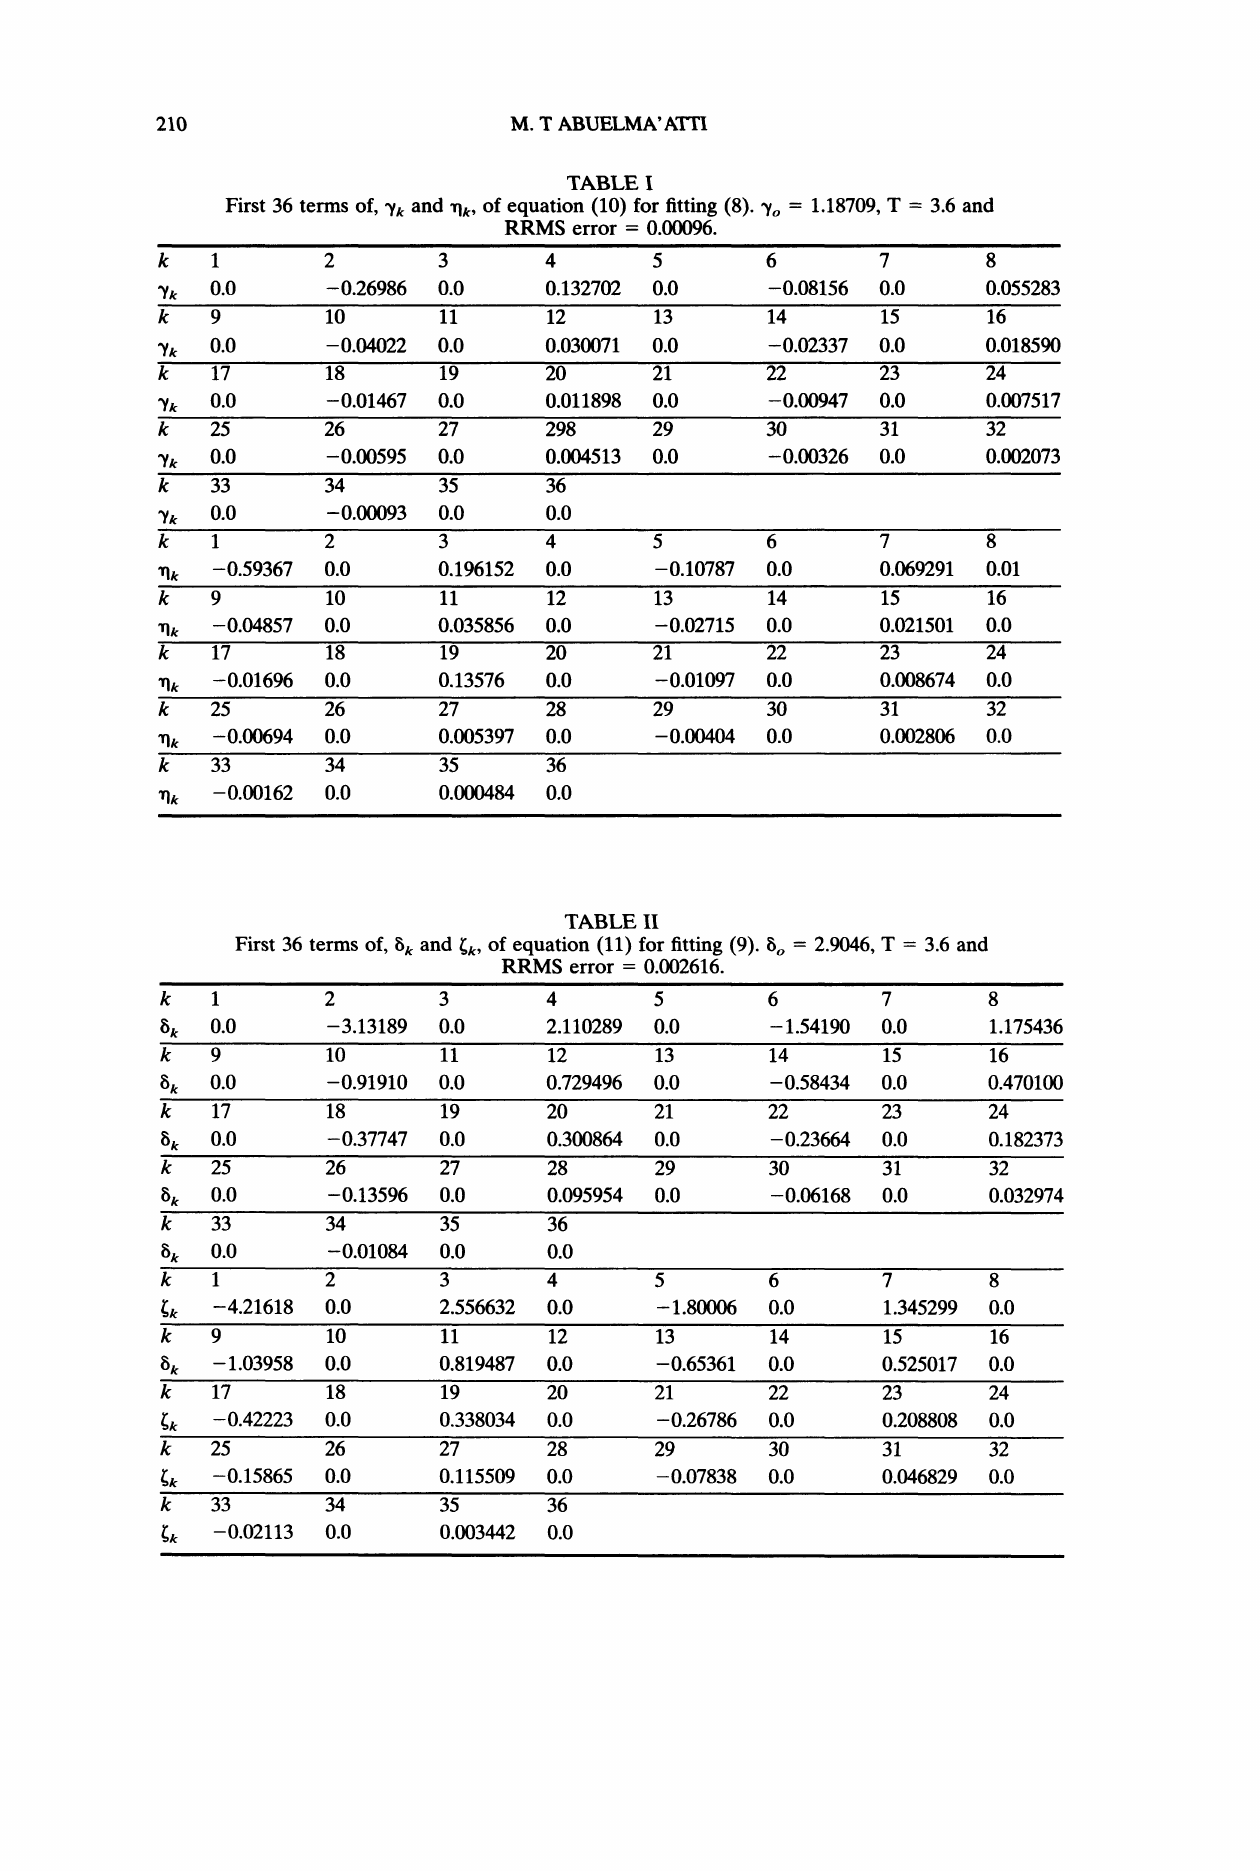
First 36 terms of, /, and q,, of equation (10) for fitting (8). "o